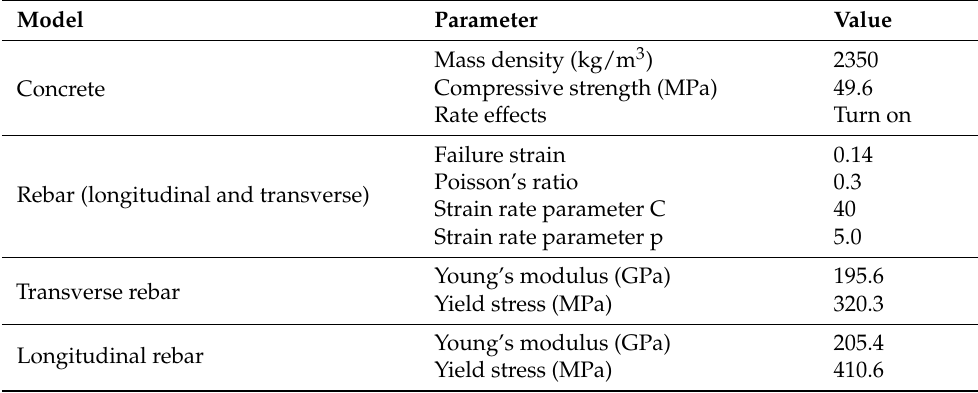
Table 1. Material properties used for I-shaped RC beams under blast